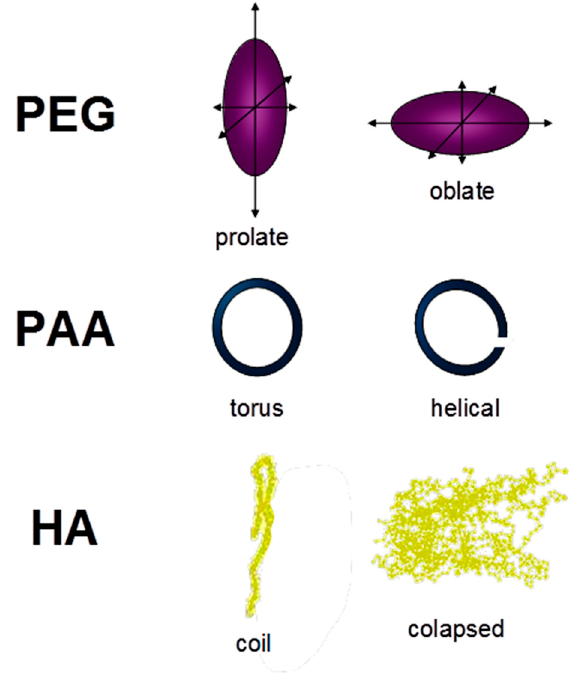
Figure 4. Different shapes proposed for PEG, PAA, and HA. PEG conformation was estimated as random chains presenting significant anisotropy and giving PEG axes like prolate or oblate spheroids. PAA conformation changes from low to high ionic strength showed a variation between a torus and a helical shape. HA could form extended random coils at neutral pH but more collapsed structures at low pH.